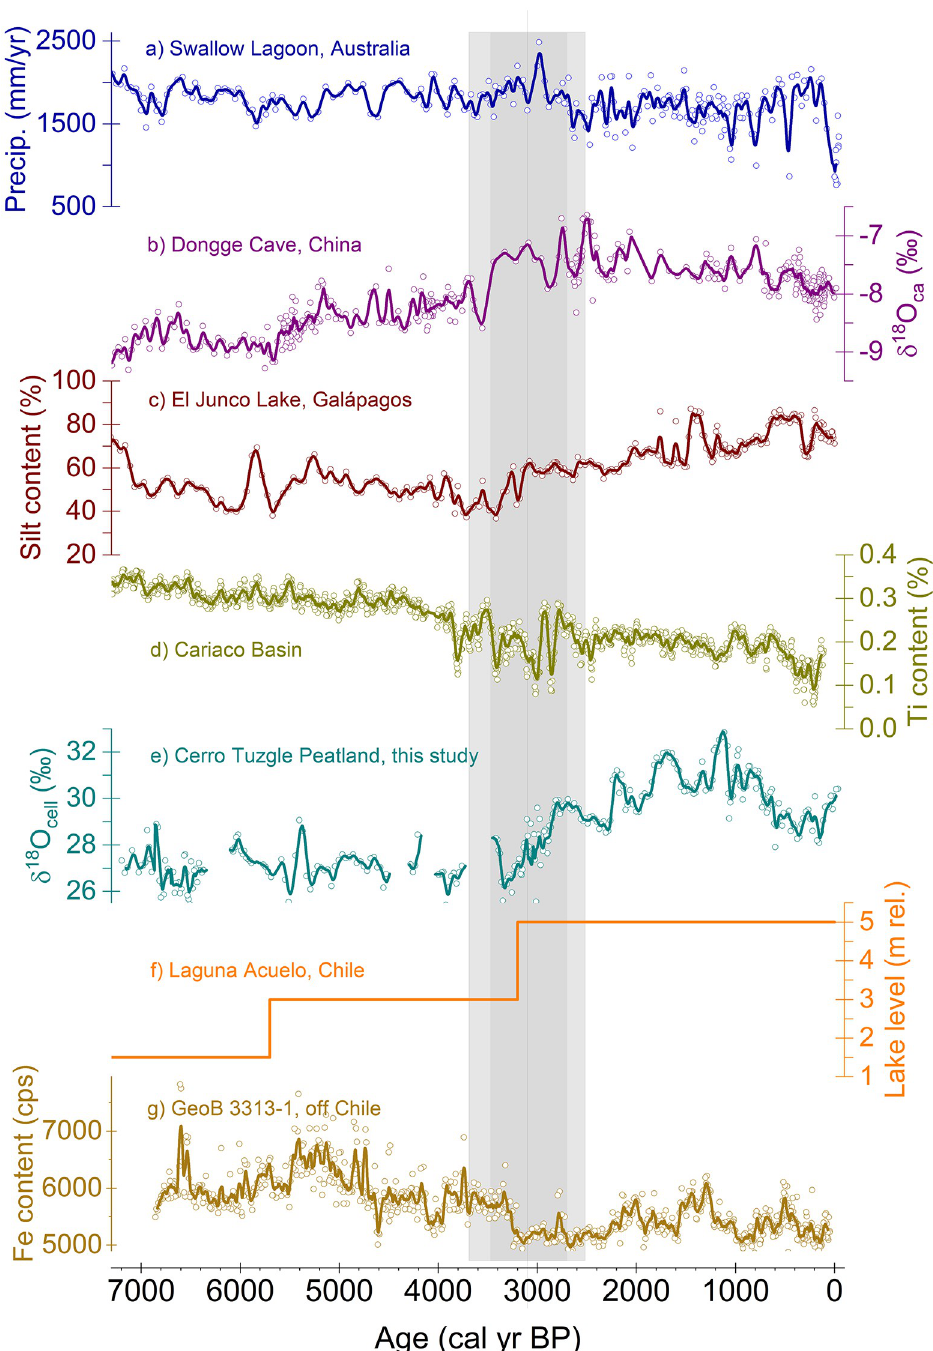
Fig 7. CTP record and Circum Pacific archives. (a) Subtropical Australian precipitation as proxy for Holocene ENSO behaviour [80]. (b) Stalagmite δ 18 O from Dongge Cave, southern China, as proxy for strength of Asian monsoon [79]– increasing values indicate decreasing precipitation. (c) Silt content of El Junco lake sediment, Gala´pagos Islands [78] as proxy for Holocene ENSO behavior–increasing silt content indicates increasing precipitation. (d) Cariaco Basin Ti content as proxy for the ITCZ position [71]. (e) Cellulose δ 18 O from the CTP, Argentina, as hydroclimatic proxy. (f) Lake level of Laguna Acuelo, central Chile [73]–higher lake level indicates increasing precipitation. (g) Iron content of marine core GeoB 3313–1 off Chile as proxy for rainfall variability derived from SHW [14]–lower iron contents indicate more humid conditions. Note that the age model of GeoB 3313–1 was recalculated with Bacon based on the marine radiocarbon age calibration curve Marine20 [75]. The records are annualized and averaged with a